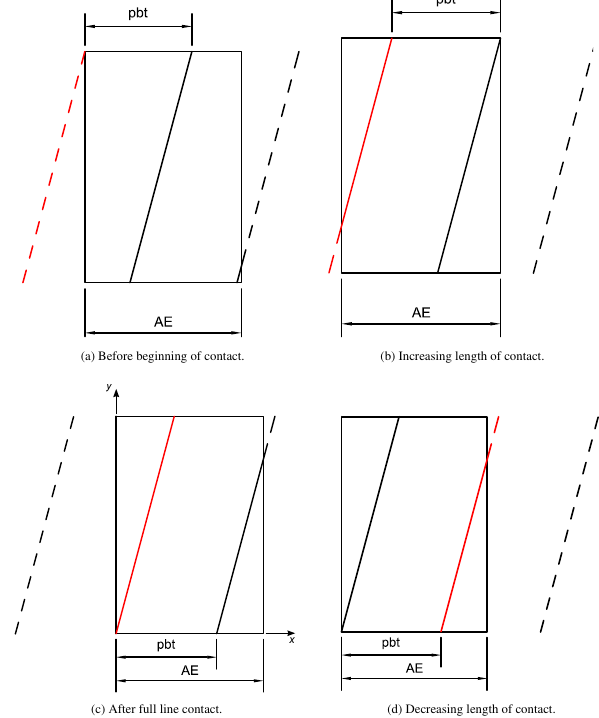
Figure A1. Evolution of a single line along the path of